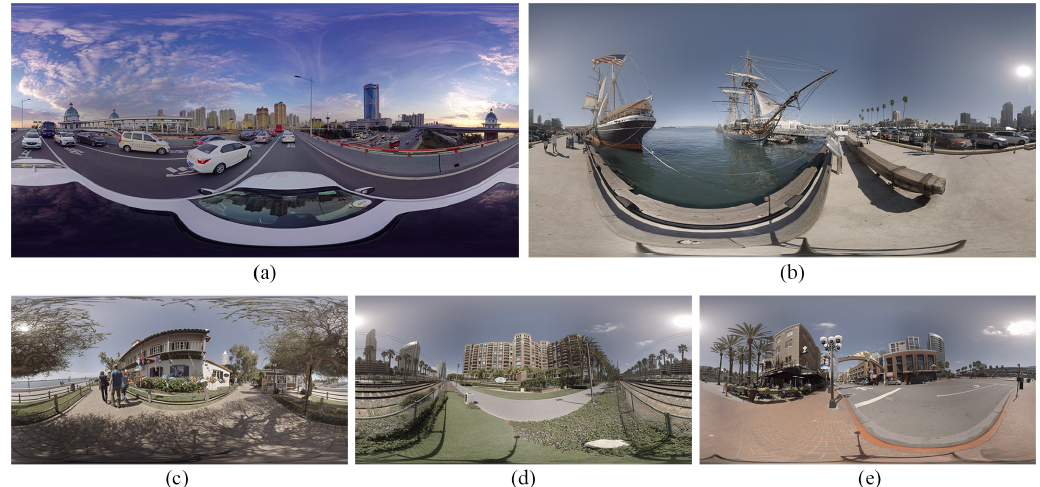
Figure 13. The 360 video test sequences: ( a ) DrivingInCity; ( b ) Harbor; ( c ) KiteFlite; ( d ) Trolley; and ( e ) GasLamp.